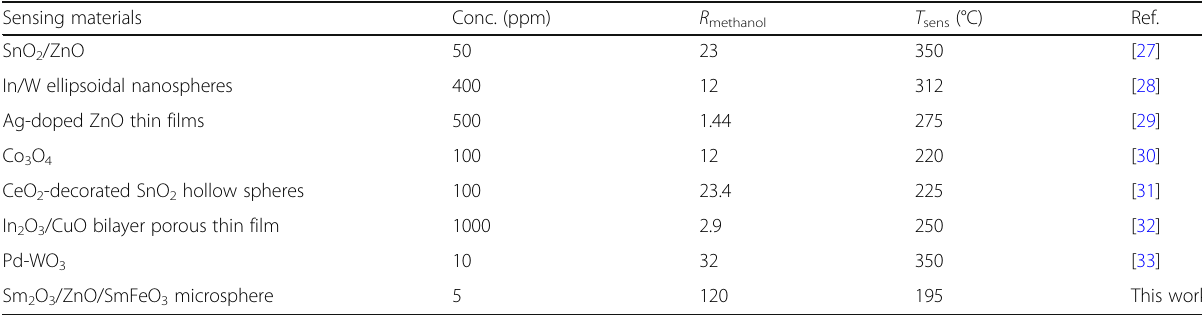
Table 2 Comparison of gas-sensing properties for methanol gas of various metal oxides with different morphologies Sensing materials Conc. (ppm) R methanol T sens (°C)